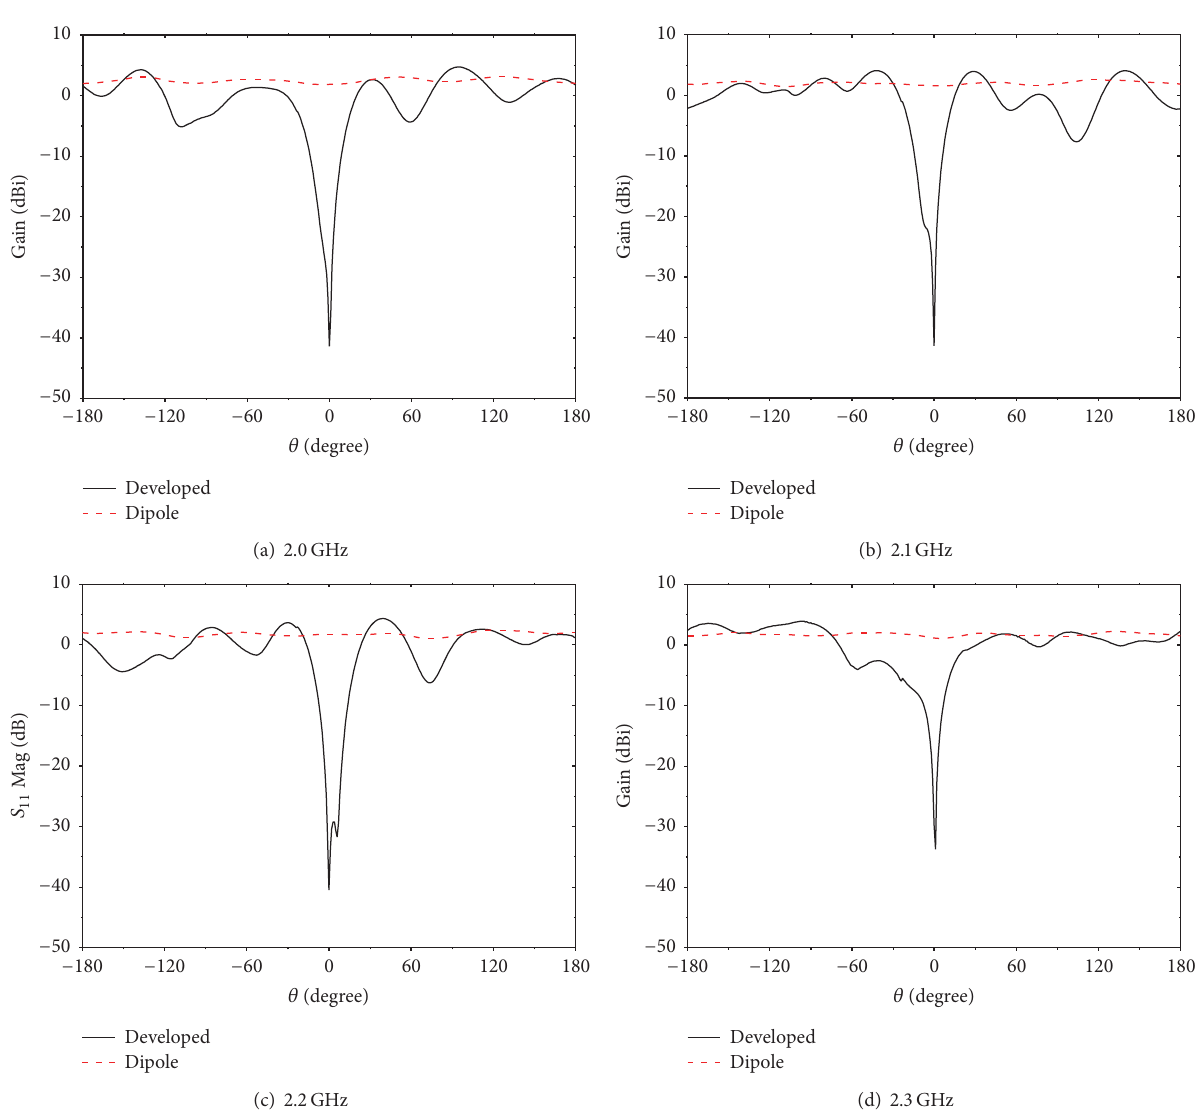
Figure 15: Nulling mode radiation patterns of the developed antenna from 2.0 GHz to 2.3